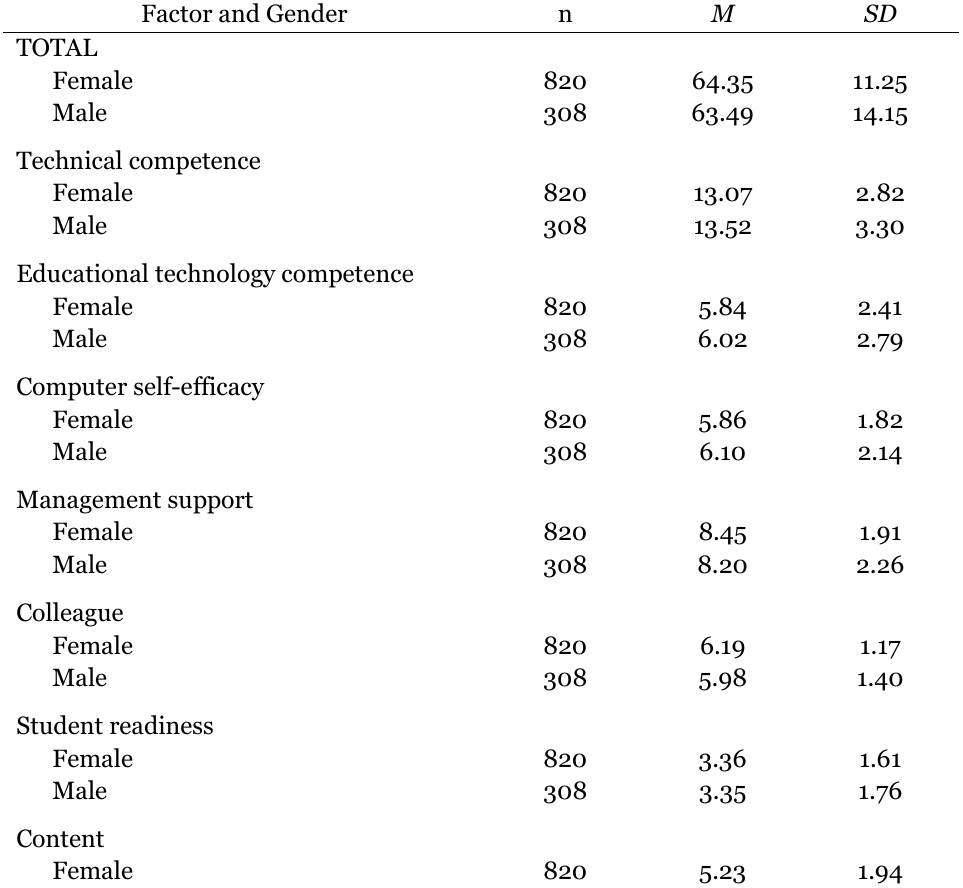
Gender Differences in